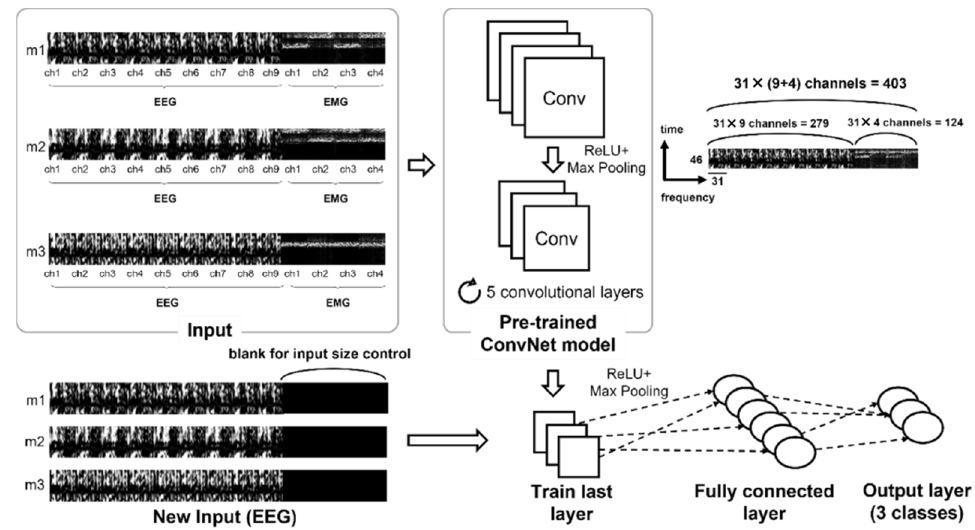
Figure 5. Input data format. Gray scaled ERDS map images generated using EEG signals from nine selected channels and EMG signals from four selected channels. “m1” refers to the movement of wrist dorsiflexion and volar flexion, “m2” refers to the movement of wrist radial deviation and ulnar deviation, and “m3” refers to the movement of hand grasping and opening .